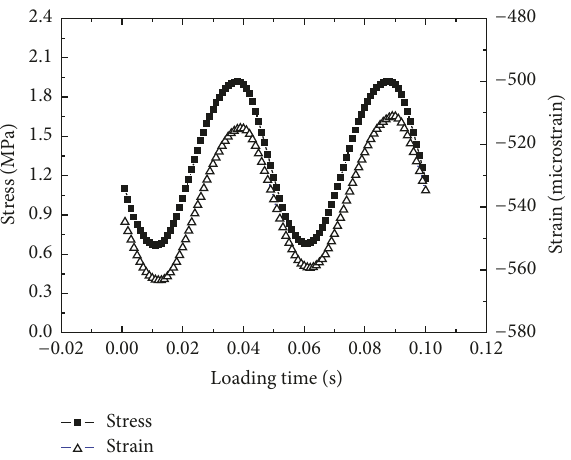
Figure 2: Applied stress and strain responses at 20